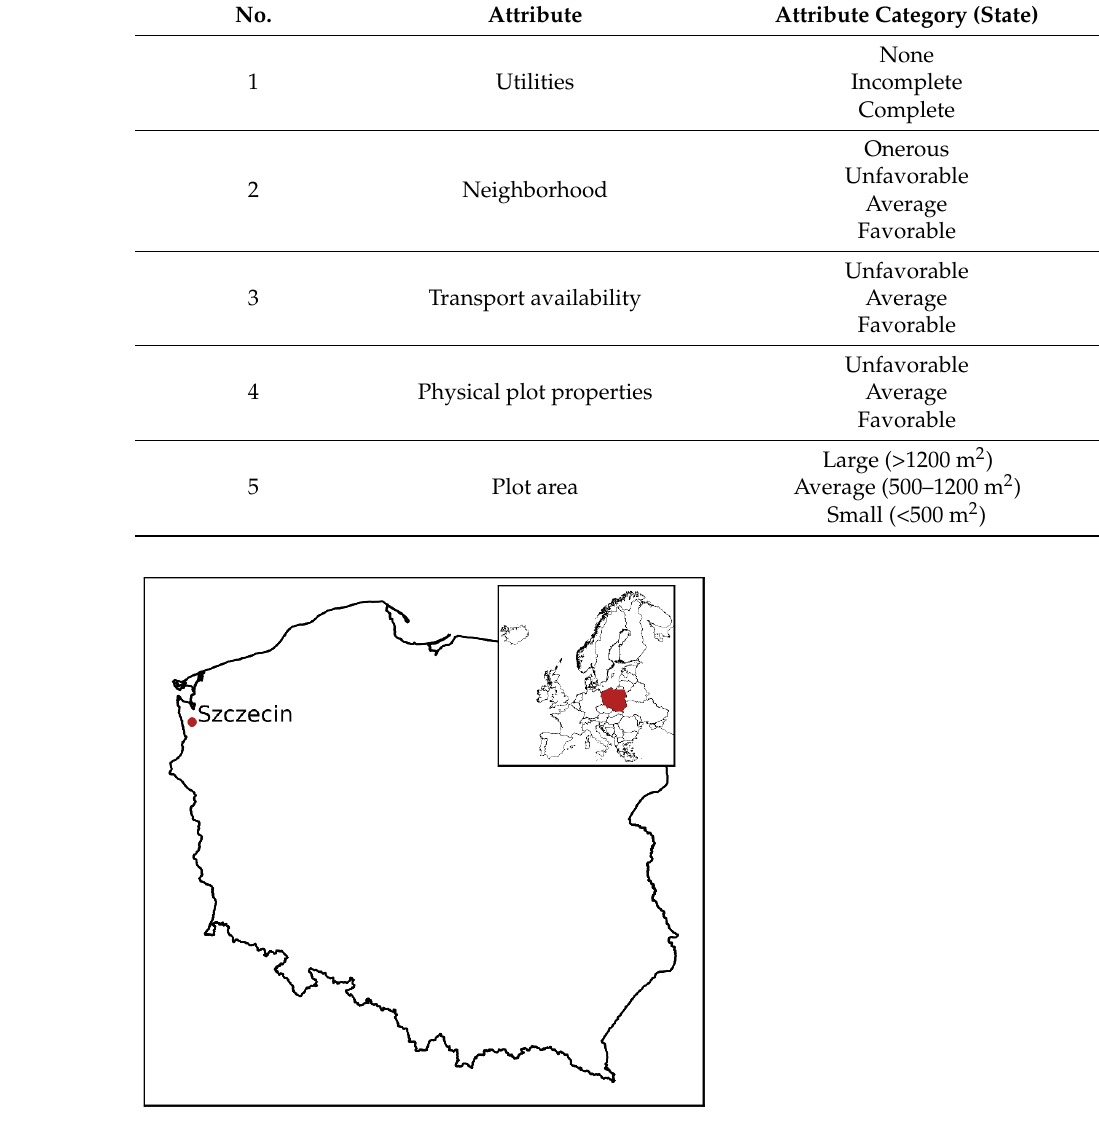
Figure 1. Location of the city of Szczecin within Poland.